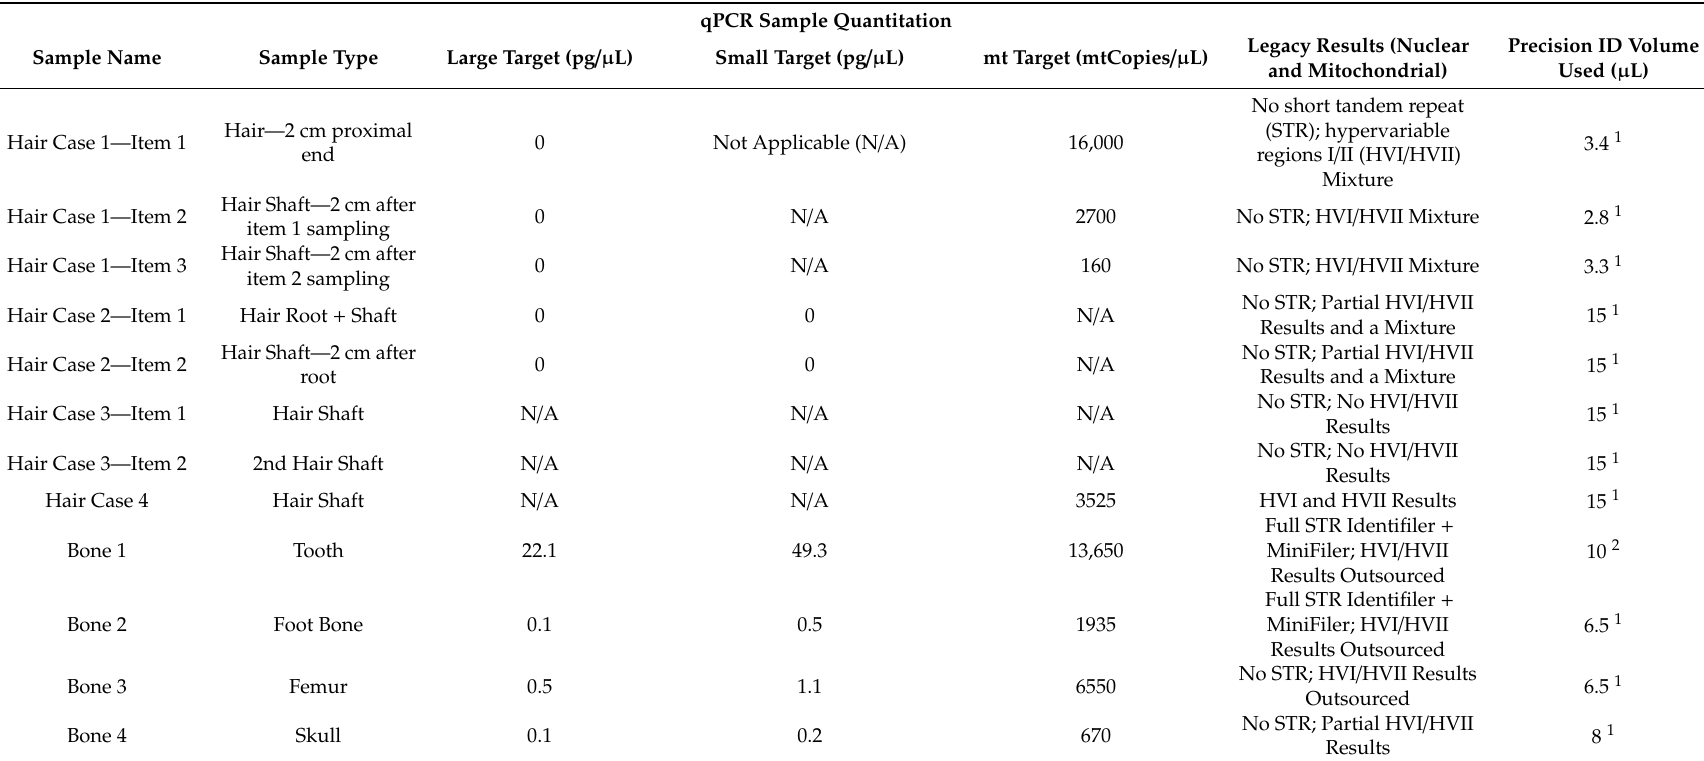
Table 1. Samples Description Table. The table shows sample name, sample type, DNA concentration, legacy results, and Precision ID (PID) amplification volume used. STR and Sanger sequencing was attempted for all samples, “No STR” or “No HVI / HVII results” indicate unsuccessful results. Not every sample was quantified with both autosomal and mitochondrial targets; cells that show N / A indicate that sample was not quantified using that target. In the Volume Used column dilution is abbreviated to